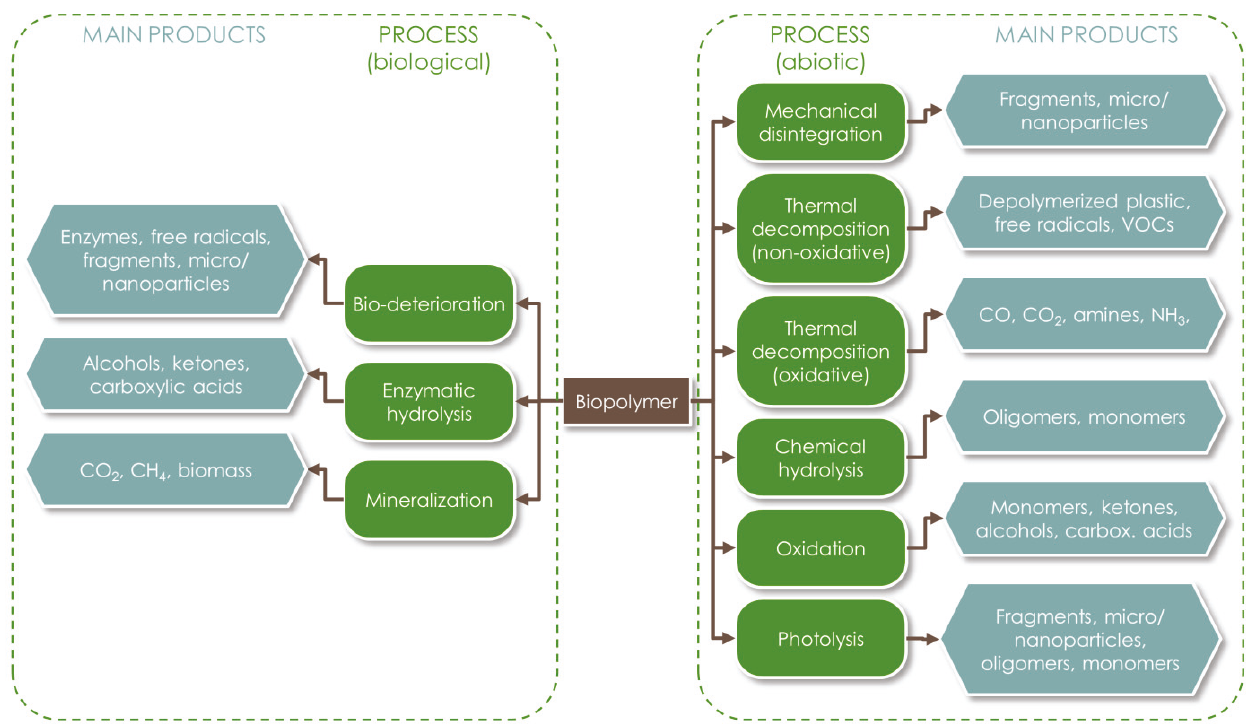
Figure 1. Main abiotic and biotic degradation mechanisms of biopolymers and related